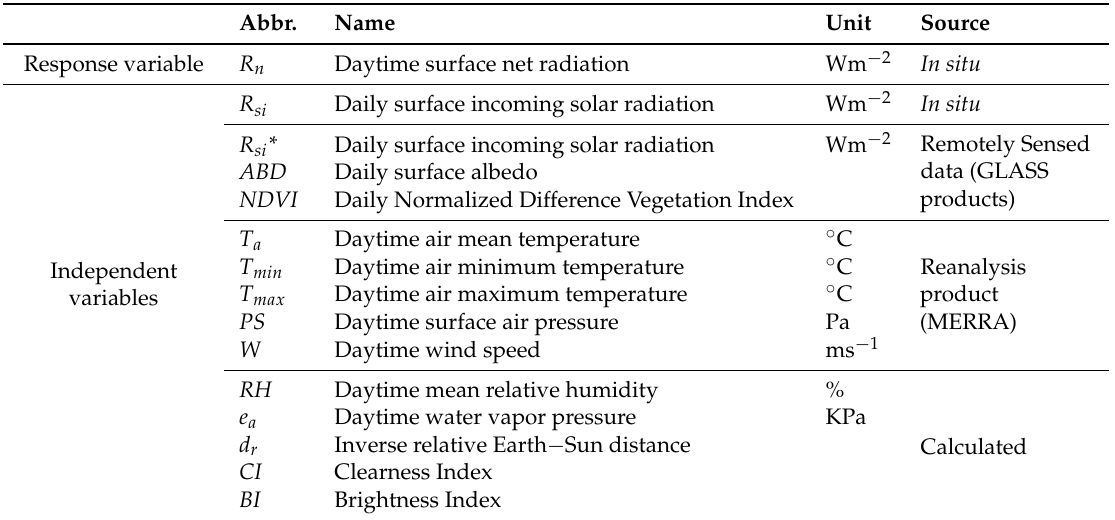
Table 2. Variables explanation and